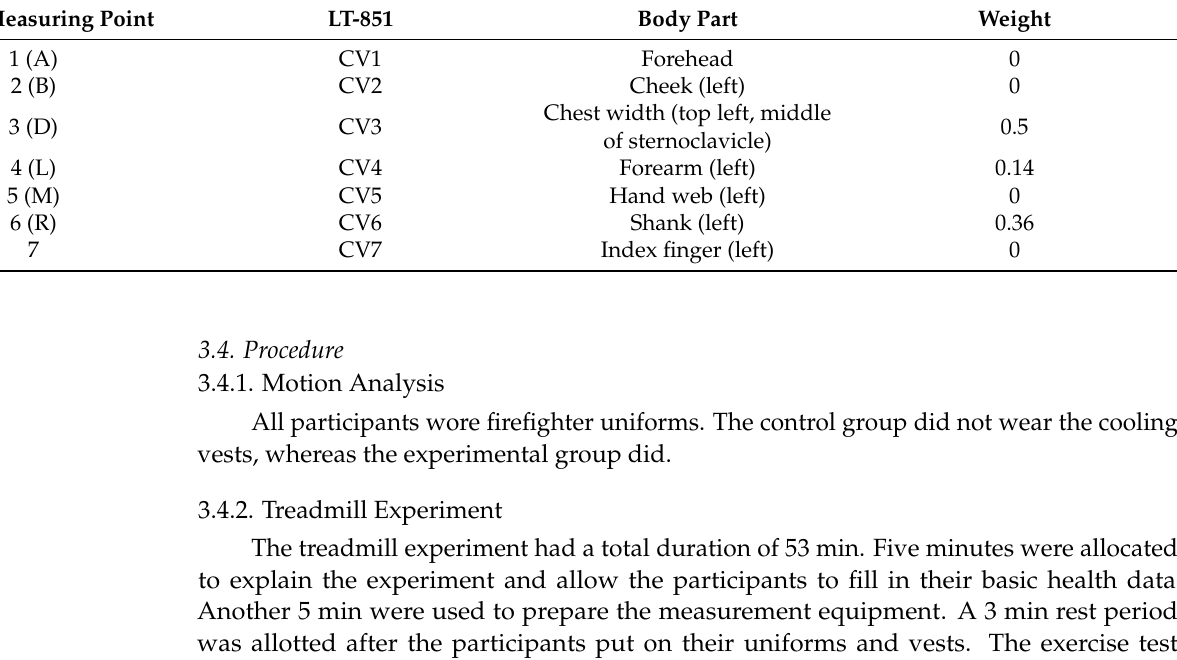
Table 3. Skin temperature measurement